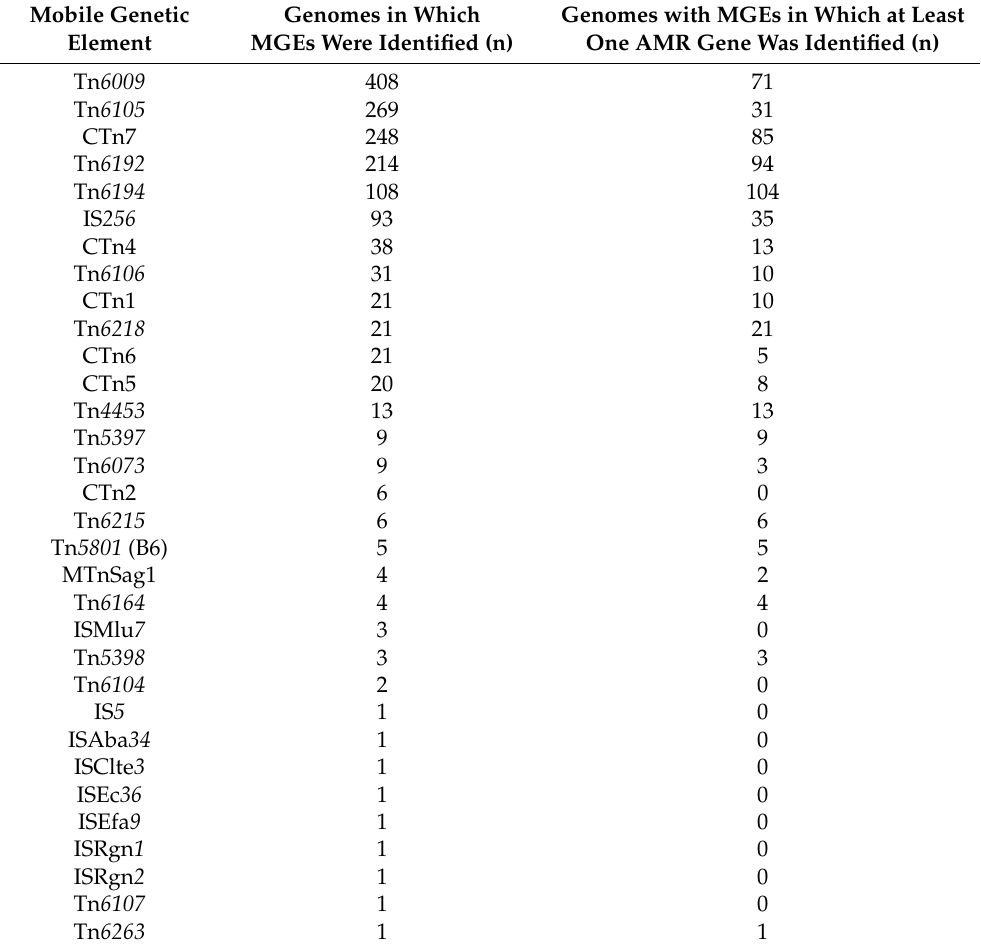
Table 1. Frequency of mobile genetic elements in 1101 genomes of C. difficile available in the GenBank database 1,2 .